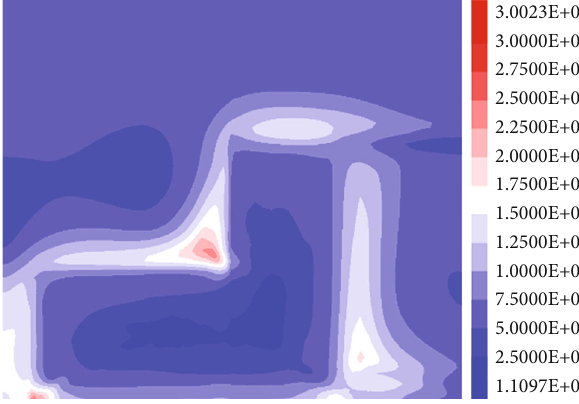
Figure 26: Maximum shear stress of mutative mining